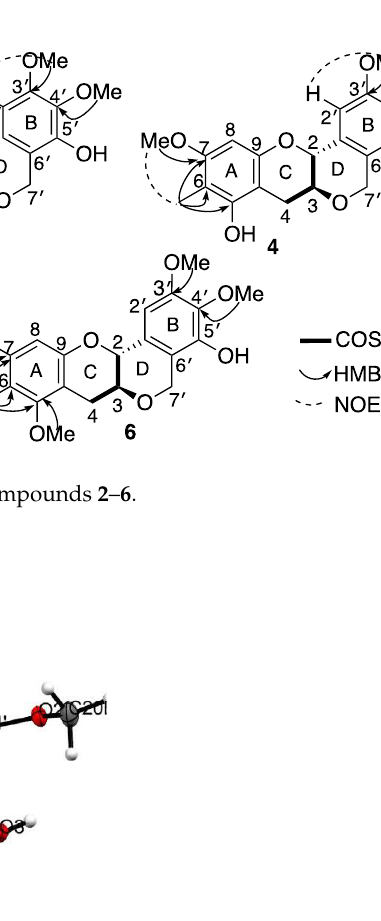
Table 2. 13 C NMR data for compounds 1 – 6 .